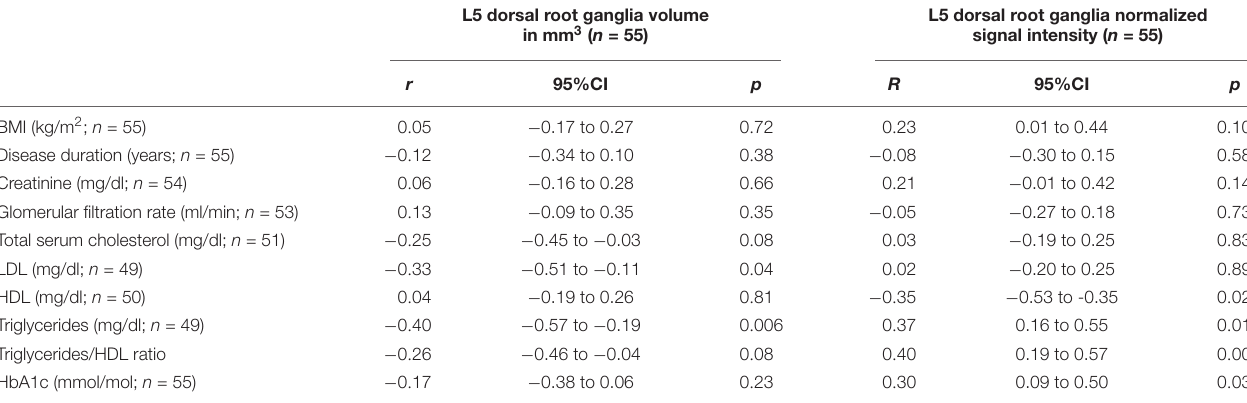
TABLE 3 | Correlation of dorsal root ganglia volume and normalized signal intensity with demographic and serologic